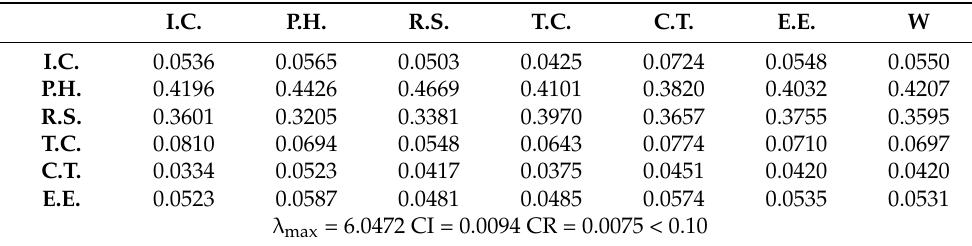
Table 6. Normalized criteria pair-wise comparison matrix, priority vector (W), and consistency control.